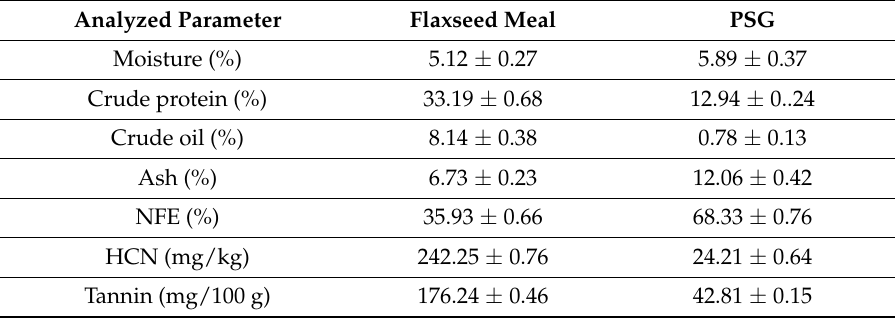
Table 2. Comparison of chemical characterization of Flaxseed meal and PSG.